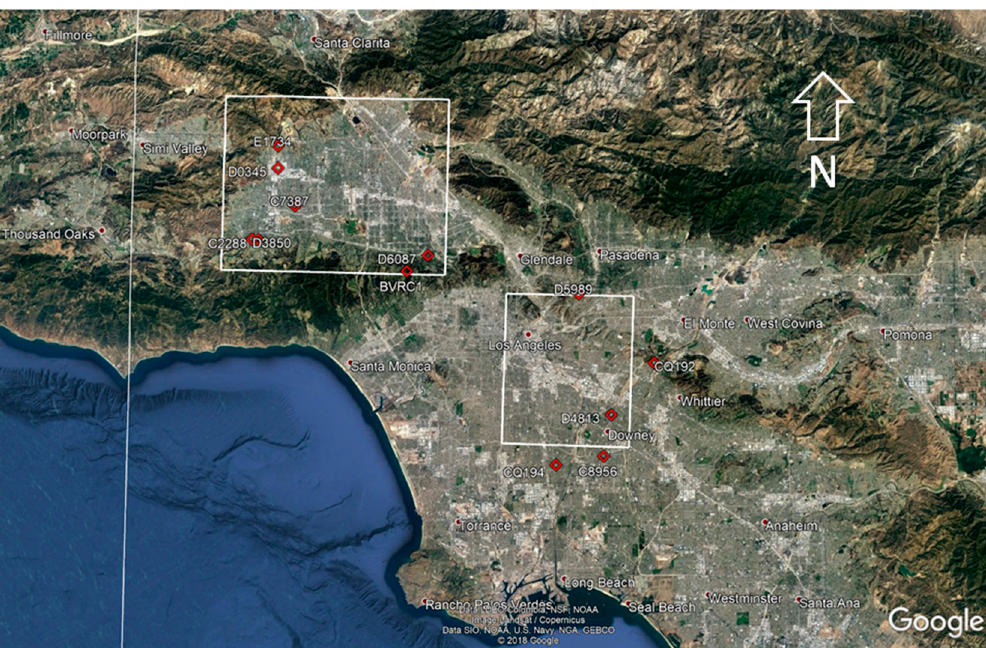
Figure 1. Urban WRF 500-m modeling domains for San Fernando Valley (left rectangle) and downtown area (right rectangle). Red diamonds locate the mesoscale network (mesonet) monitors closest to either domain. Downtown Los Angeles is near the northwest corner of the right rectangle.